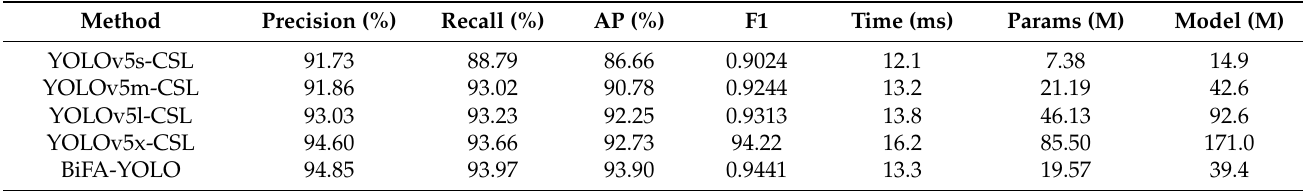
Table 7. Comparison of different models using the CSL on SSDD.